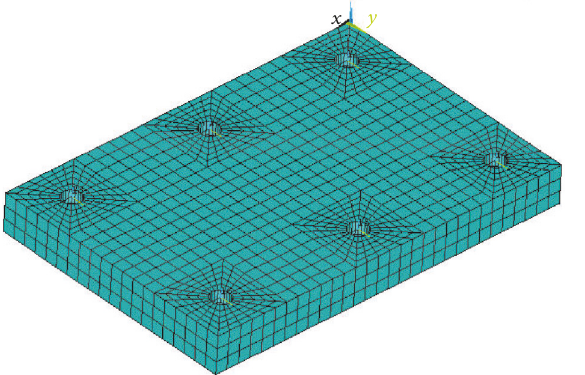
Figure 1: Finite element model and its mesh